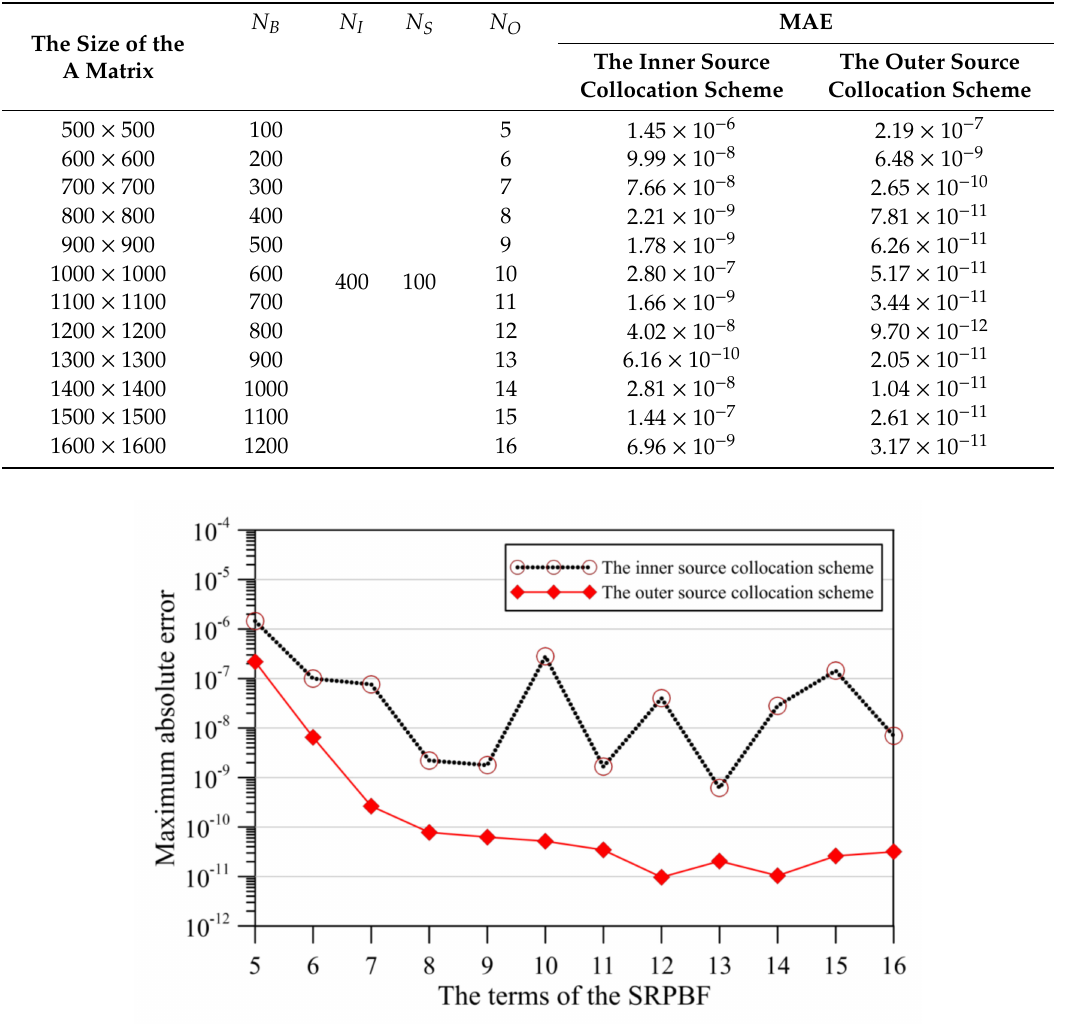
Figure 4. The maximum absolute error versus the terms of the